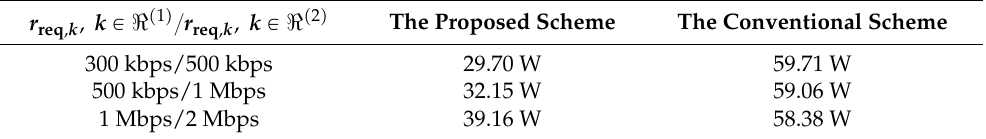
Table 1. The average levels of total power consumption, under the proposed scheme and the conventional scheme, when the minimum required data rates for NRT users and RT users are set at different levels given the traffic pattern indicated in Figure